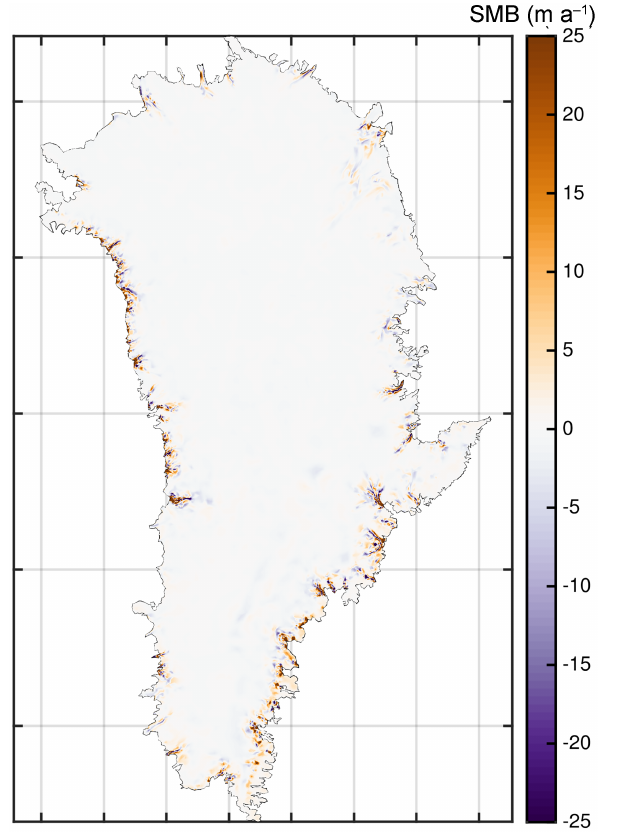
Figure 6. Synthetic surface mass balance SMB corr calculated from a single year unforced relaxation run (truncated at − 25 and 25ma − 1 ). As the SMB corr will be subtracted in Eq. (8) positive values represent enforced thinning, and negative values